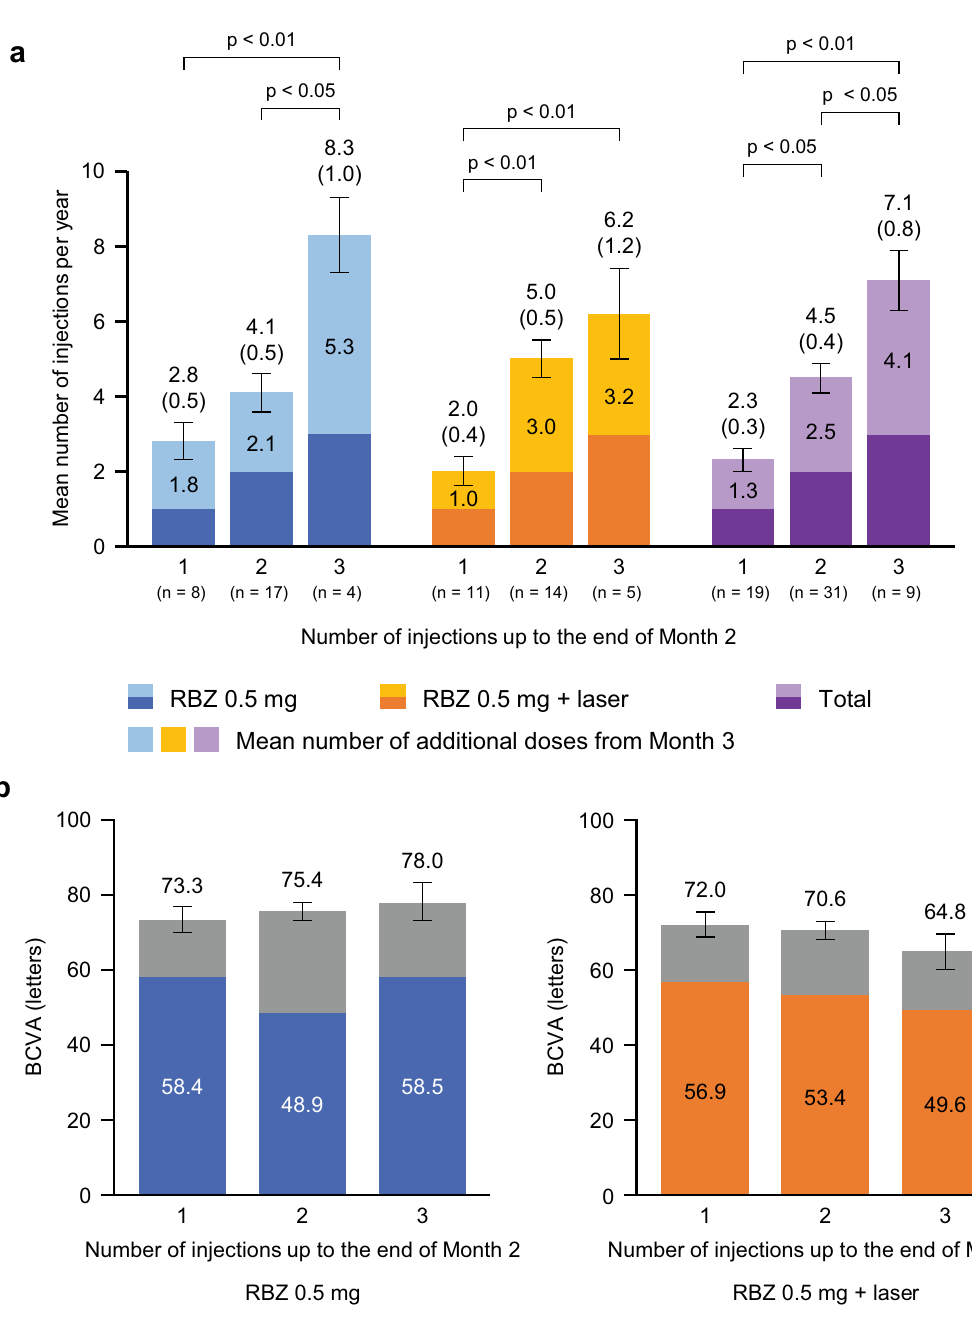
Figure 1. ( a ) Number of ranibizumab injections per year (SE) according to the number of injections administered up to the end of Month 2 (safety analysis set). ( b ) Corresponding mean (SE) visual acuity (letters) at Month 12. p values obtained from t -test with Tukey’s method. By analysis of variance, for 1 vs 2 vs 3 injections, p < 0.01. In ( b ), the colored bars represent the BCVA at baseline and the gray bar represents the BCVA at Month 12. BCVA best corrected visual acuity, RBZ ranibizumab, SE standard